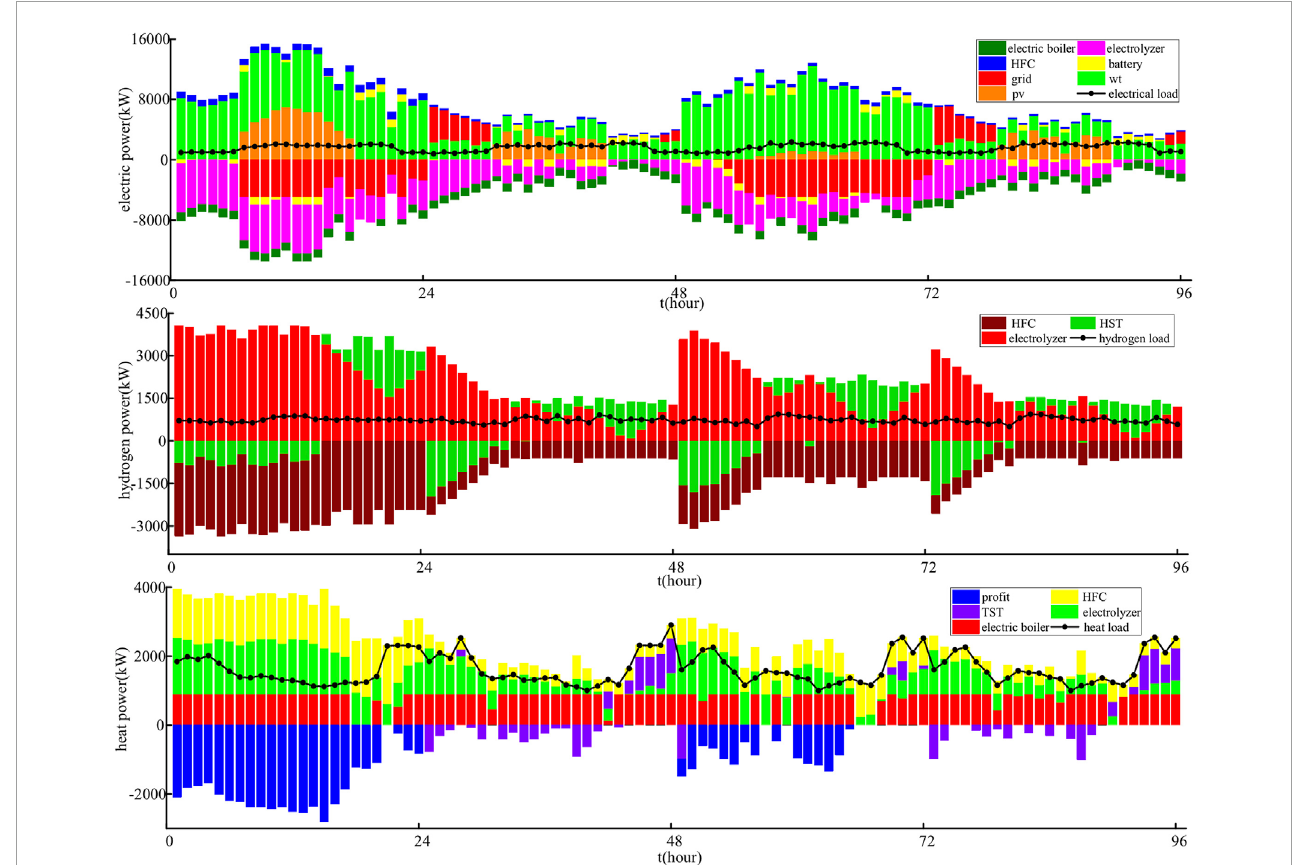
FIGURE 10 Power balance of different energy sources in case